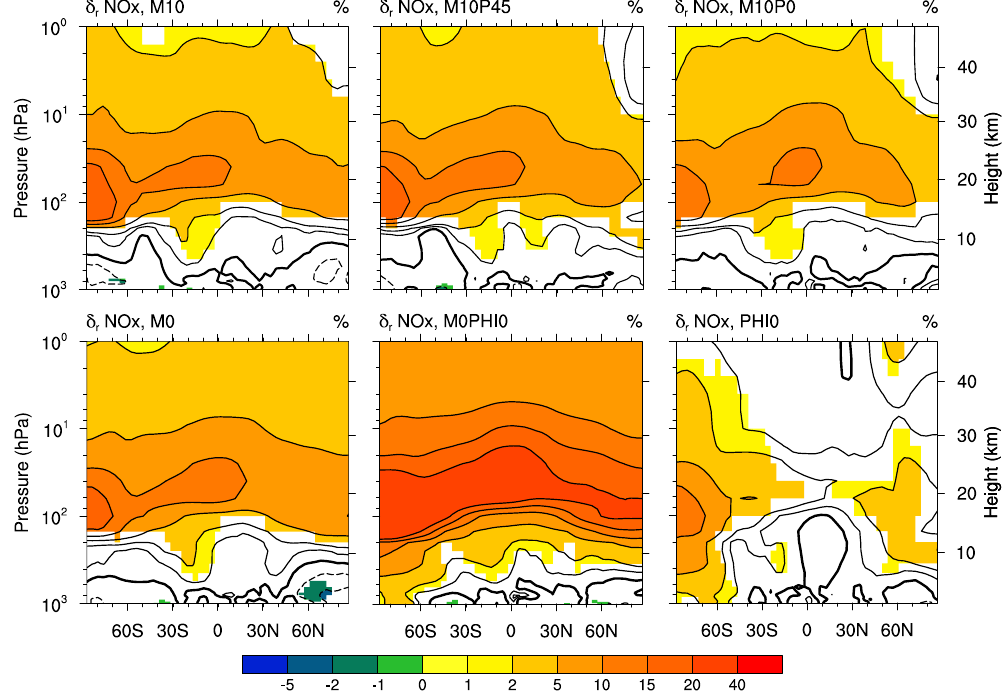
Figure 1. Simulated effects on zonally averaged mean annual NO x concentrations. The relative difference is defined as ( [ X ] exp −[ X ] ref )/ [ X ] ref . Coloured areas are significant at a 5% level. Solid contours indicate positive, dashed contours negative